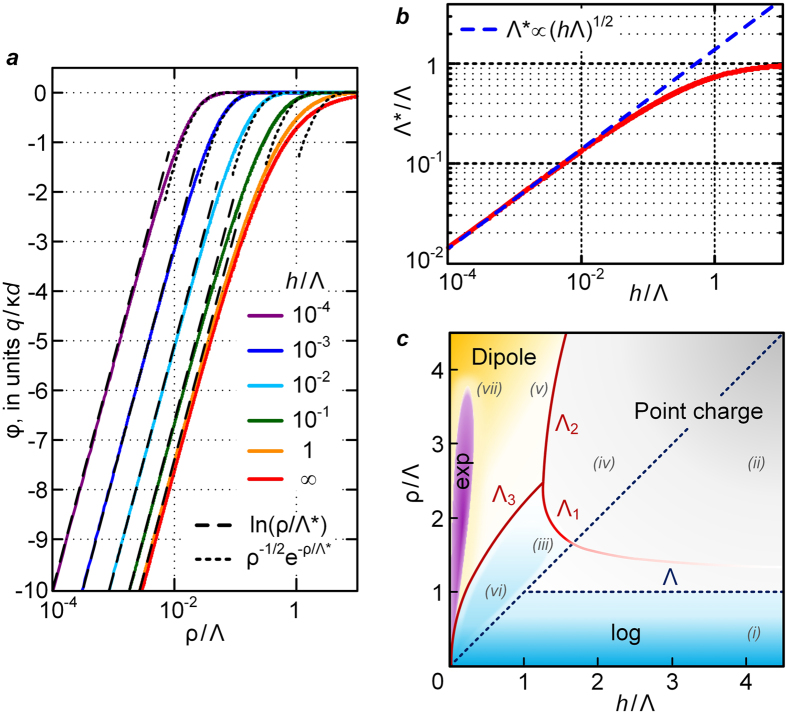
The electrostatic potential in the presence of the gate and the sketch of the regimes of electrostatic interactions.The material dielectric parameters are the same as in Fig. 1b. The distances are measured in units of the fundamental screening length Λ and the potential in units q/κd. (a) Semi-log plots of the electrostatic potential of the point charge placed in the middle of the film as functions of the distance for various values of the spacer, h/Λ, increasing from the top to the bottom. The straight dotted lines are fits to  dependencies at small distances from which we determine the screening lengths Λ* at different h. The dashed lines stand for the  dependencies, which provide pretty fair fits for the long-distance behaviour of φ(ρ) at small . (b) The log-log plot of the Λ* on h dependence determined from the data given in panel (a). At small separations between the gate and the film, , the effective screening length follows the law , at larger h the noticeable deviation from this dependence is observed and at  it tends to Λ. (c) The map visualizing the different interaction regimes between charges in the h−ρ coordinates. The gate-dominated regime takes place at ρ < h, i.e. above the dashed diagonal line. Below this line the interaction is only slightly affected by the gate. The regions with the logarithmic interaction, lying at small ρ are highlighted by the blueish colours. This 2D logarithmic interaction becomes screened at distances beyond the screening length. The latter can acquire either of the values Λ, Λ1 or Λ3, depending on the parameters of the system. In the screened regime, the charges interact either as 3D point charges (grayish region, on the right of the separating line Λ2) or as the gate-imaged electric dipoles (yellowish region, on the left of Λ2). At very small gate separation the strong exponential screening takes place (the violet petal). Gray roman numerals indicate the correspondence to analytical formulae in Table 1.